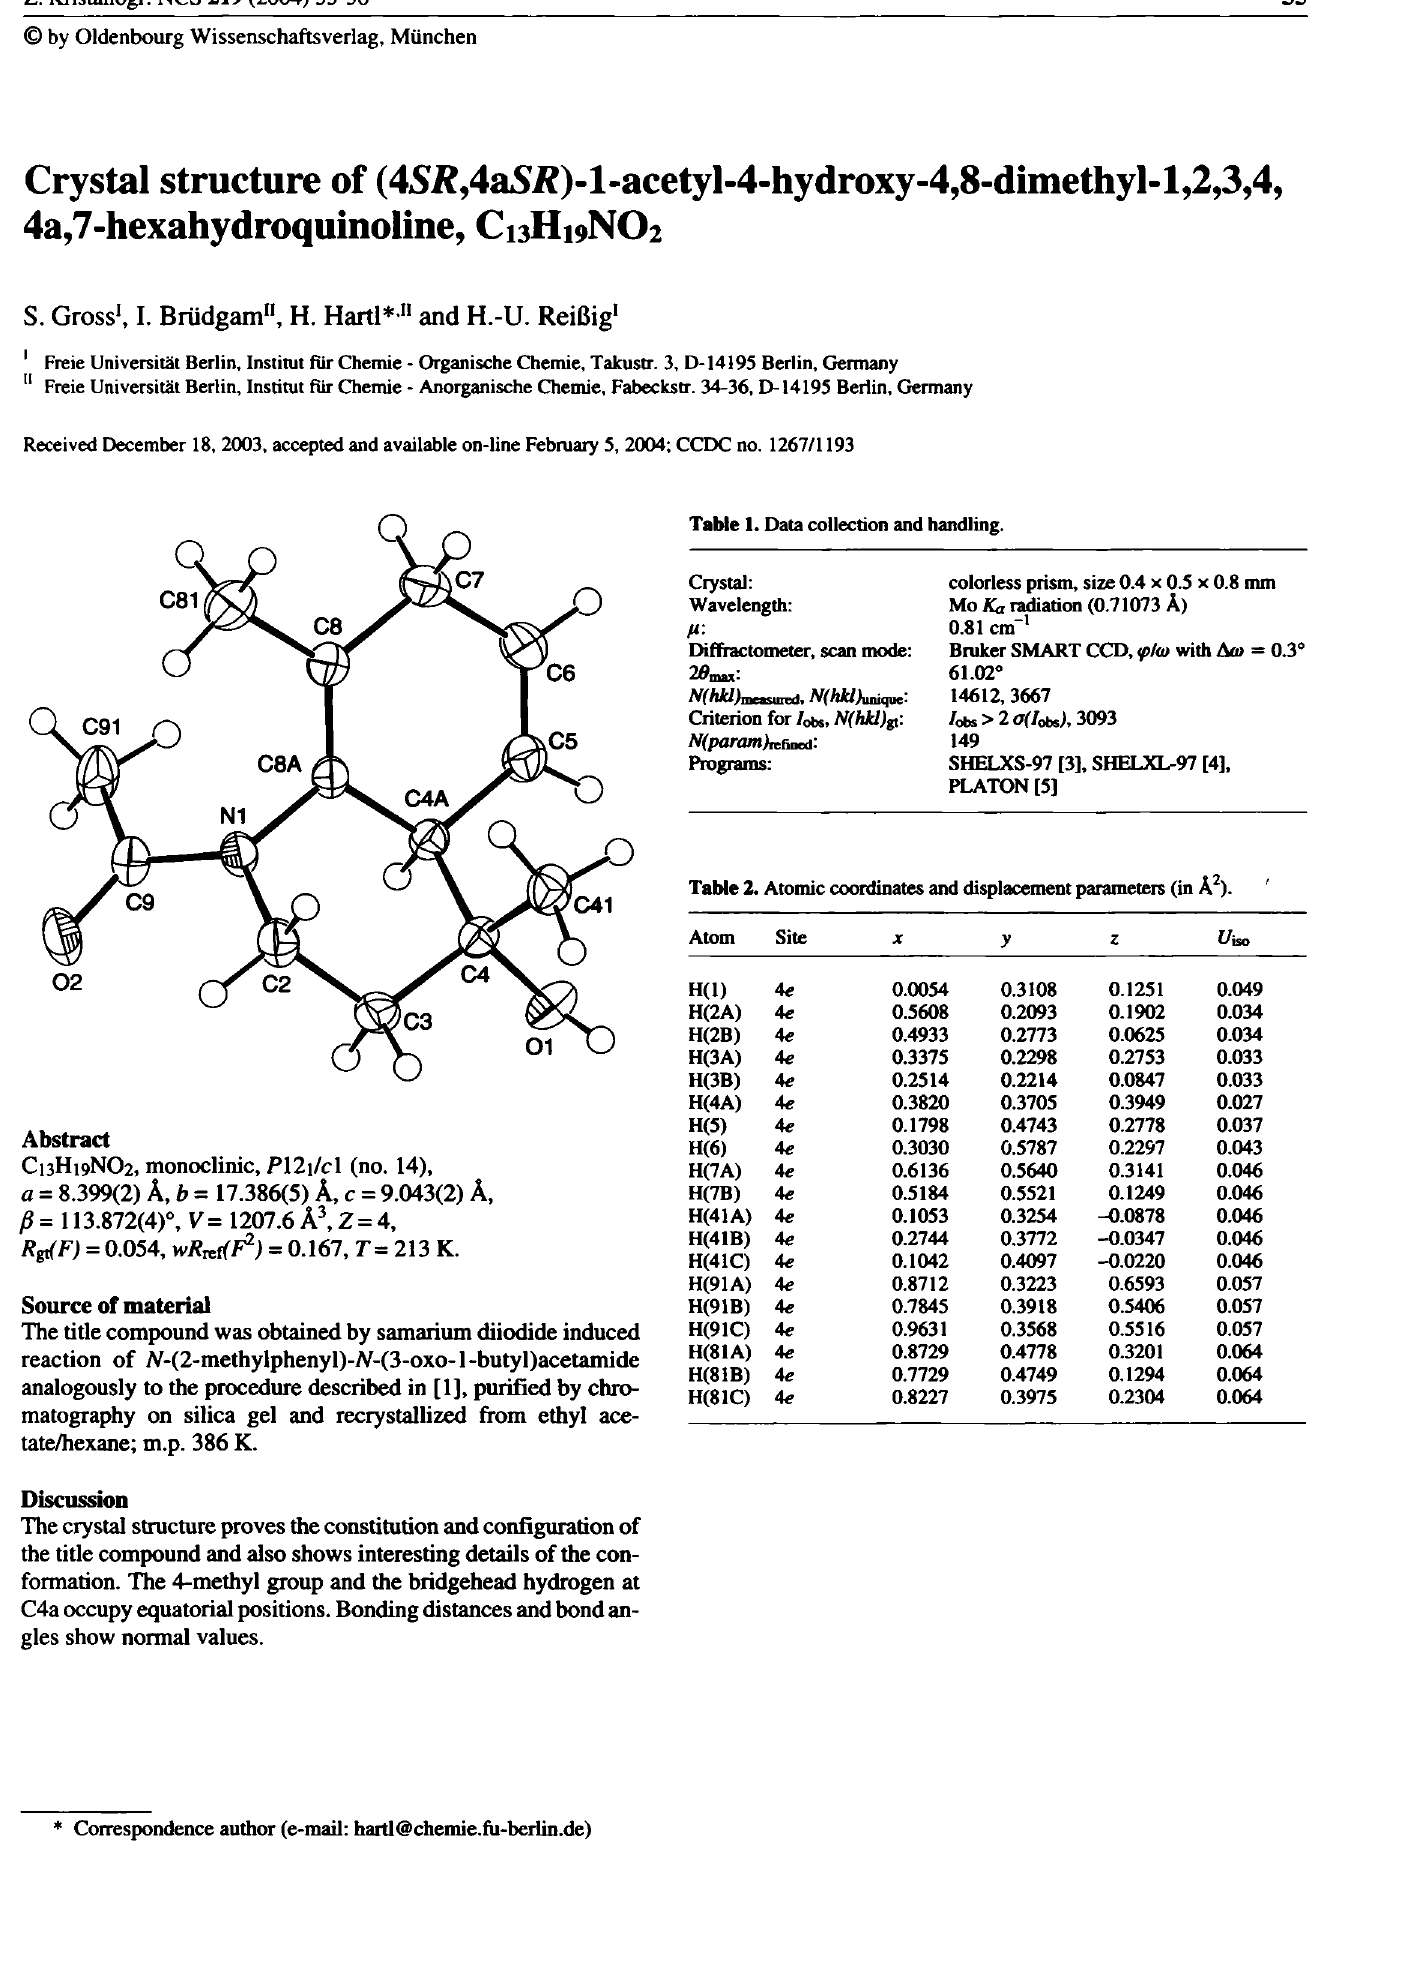
Table 1. Data collection and handling.